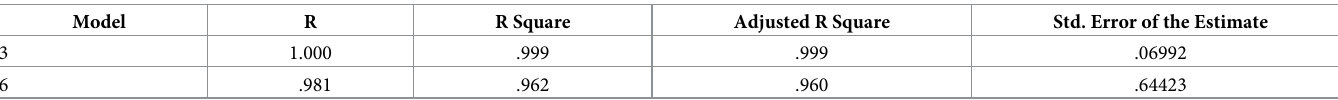
Table 11. Model summary.